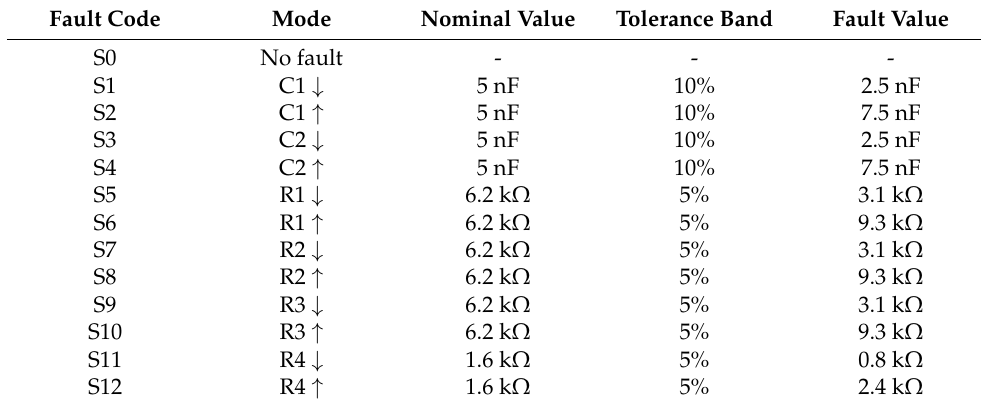
Table 3. Failure mode of the Four-opamp biquad high-pass filter